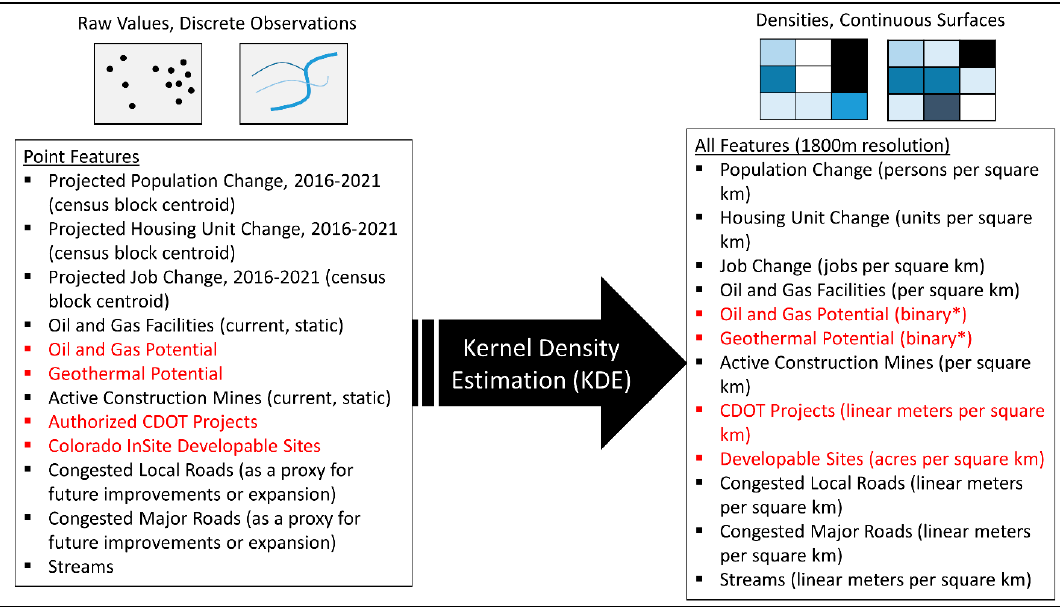
Figure A3. Using KDE to convert discrete feature distributions into equal-resolution surfaces (* indicates that KDE was not used to create these binary-valued raster datasets; see below.) Two of the red-highlighted datasets from Figure A3—CDOT authorized projects and Colorado InSite developable sites—were converted into raster surfaces using the same steps and KDE technique discussed earlier. In the former case, CDOT-authorized projects were represented as linear features in the GIS data layer. Thus, KDE was used to compute the length (in meters) of construction projects per kilometer in 1800-m resolution raster pixels. For Colorado InSite point locations, the LotSize attribute was used as a weight in KDE to compute the amount of developable land (in acres) per kilometer in the resulting raster surface. In contrast, the two remaining red-highlighted datasets from Figure A3 were treated differently. In both cases, areas of energy potential were represented by USGS EERMA as polygons. To rasterize these polygons, 1800-m resolution grid cells were assigned a value of 1 if their center fell within the polygons, and grid cells outside of the energy potential polygons were assigned a value of 0. Thus, the asterisks in Figure A3 indicate that the two flagged datasets were not generated with KDE, but were instead created by a simpler binary assignment